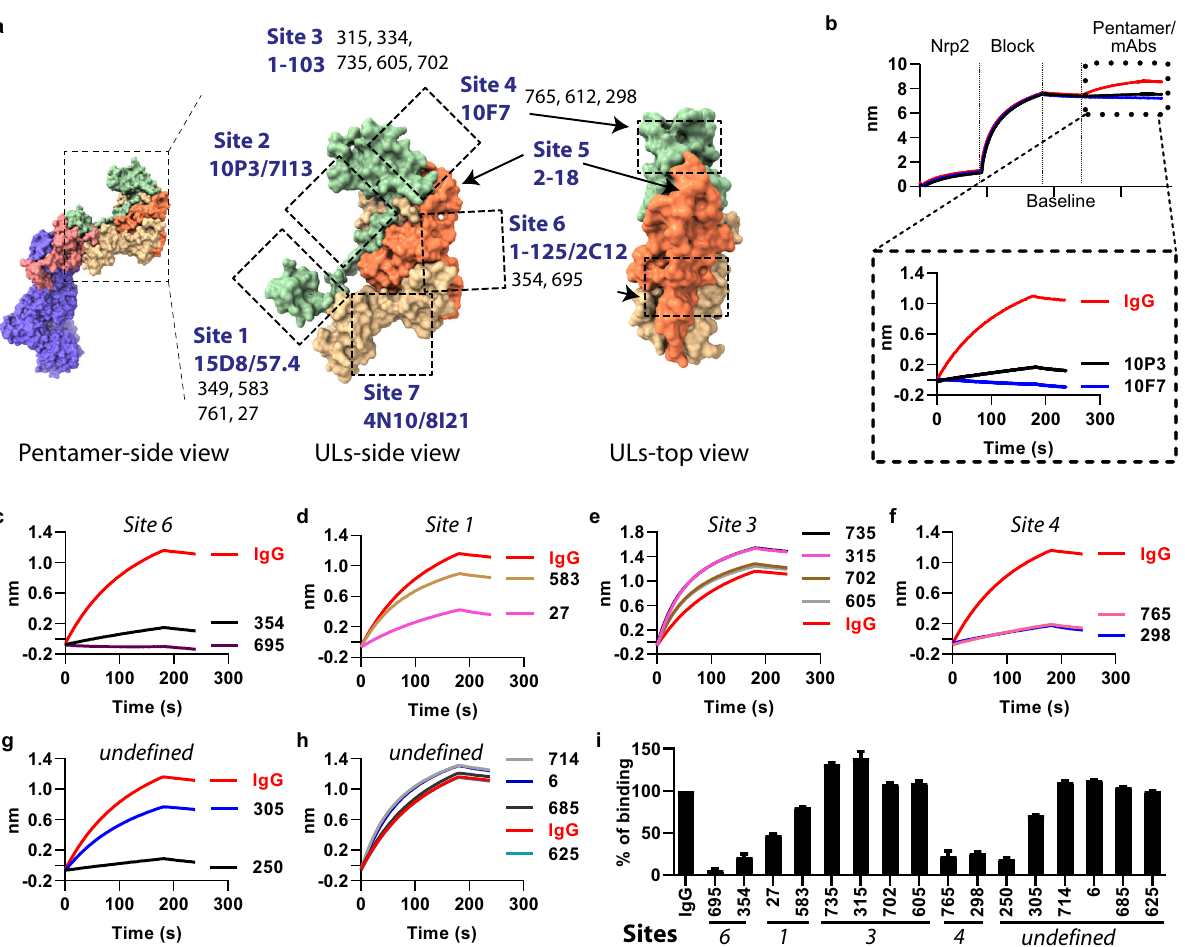
Fig. 3 Epitope mapping of pentamer-speci fi c mAbs. The binding sites of pentamer-speci fi c antibodies were mapped by competitive ELISA and biolayer interferometry (BLI) assay. a Structure of pentamer (PDB: 5VOD) and antibody-binding sites. Pentamer mAbs bind to seven reported sites (sites 1 – 7) mapped by reference antibodies (labeled in dark blue). The dashed rectangles and the arrows indicate antibody- binding regions. V160-induced pentamer mAbs (labeled in black) are mapped to four sites on the pentamer which include sites 1, 3, 4, and site 6. b Measuring antibody blocking of Nrp2/pentamer interaction by a BLI assay, which measures the light shifts (nm) upon changes in the thickness of the biolayer. The shift depends on the molecular weight and the af fi nity of the interactors. The Nrp2 protein was loaded on the NTA-biosensor and then incubated with the pentamer/mAb mixture. The positive control mAbs 10P3 and 10F7 inhibit pentamer binding to the Nrp2, but not the IgG control. A subset of pentamer mAbs was tested for blocking of pentamer/Nrp2 interaction as below. c Two site 6 mAbs block the Nrp2/pentamer interaction. d Two site 1 mAbs partially block the Nrp2/pentamer interaction. e Four site 3 mAbs do not block the Nrp2/pentamer interaction, the Y axis indicates the shift upon the binding of pentameric-antibody complex, the signal is higher than the pentamer alone (with IgG control). f Two site 4 mAbs block the Nrp2/pentamer interaction. g , h Antibodies with unde fi ned binding sites can be divided into blocking (mAbs-250), partially blocking (mAb-305), and non-blocking (mAbs-714, 6, 685, 625) groups. i The percentage of Nrp2/pentamer binding in the presence of pentamer-speci fi c antibodies at different binding sites normalized with the control IgG. Error bars indicate the standard deviation. The Molecular graphic images were produced using UCSF ChimeraX